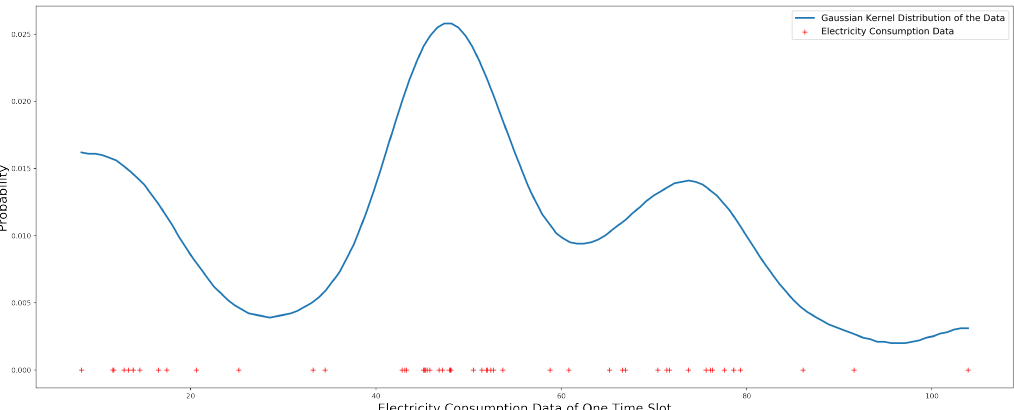
Figure 7. Gaussian kernel distribution of the first time slot’s electricity consumption data. The x -axis is the electricity consumption data. The y -axis is the probability.